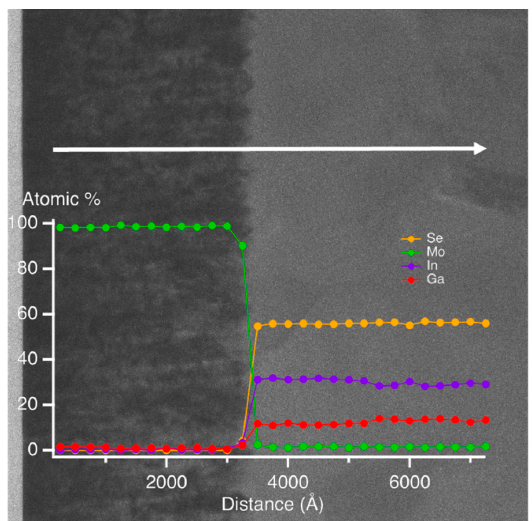
Figure 2. Cross-sectional transmission electron microscopy (TEM) image and elemental line profiles by energy-dispersive X-ray spectroscopy (EDS) for a Mo/IGS structure with IGS composition x = 0.31 highlighting the interface region. The EDS measurements were performed across the interface every 250 Å in depth.